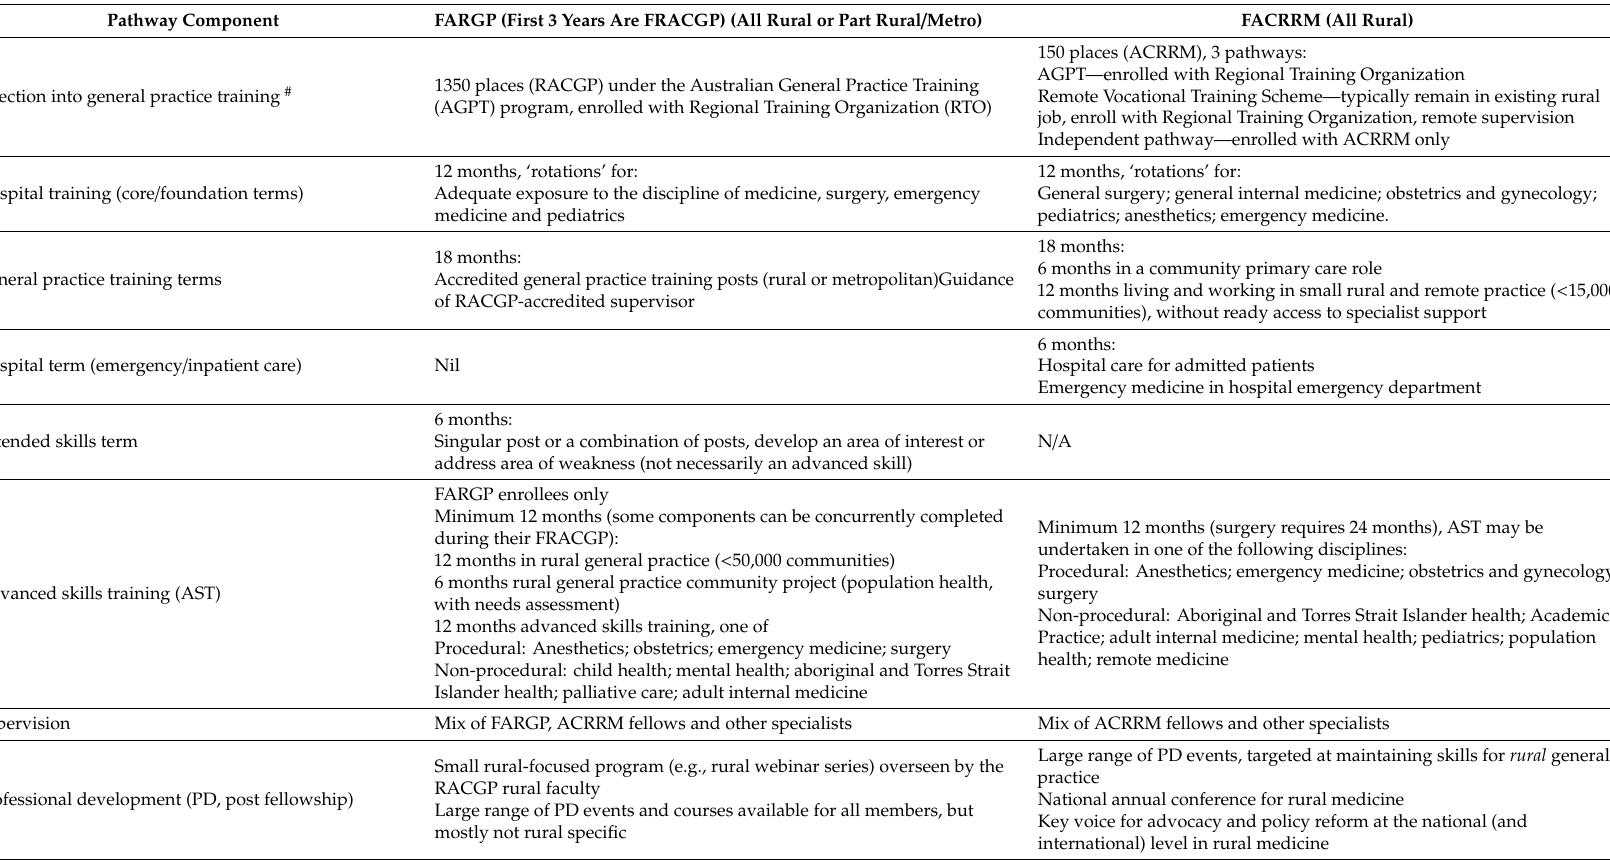
Table 1. Training pathway to attaining either FARGP or FACCRM